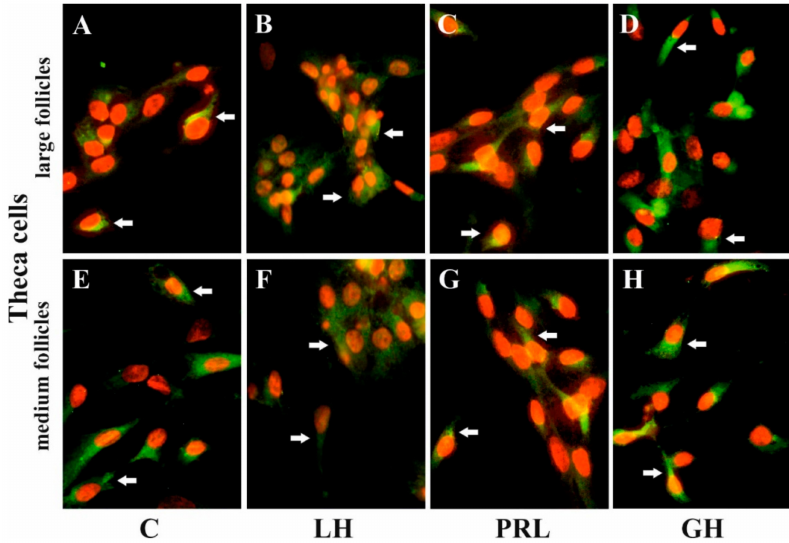
Figure 6. The influence of LH, PRL, and GH on the subcellular distribution of AQP5 in Tc of porcine ovarian follicles. After being exposed to LH ( B,F ), PRL ( C,G ), and GH ( D,H ) for 24 h, Tc were incubated with anti-AQP5 antibody and visualized with Alexa-488 (in green). Nuclei were stained with propidium iodide (in red). Arrow indicates the localization of AQP5 in the cells. The data are representative of five individual experiments, each carried out in duplicate. C: control ( A,E ); magnification of 600 ×